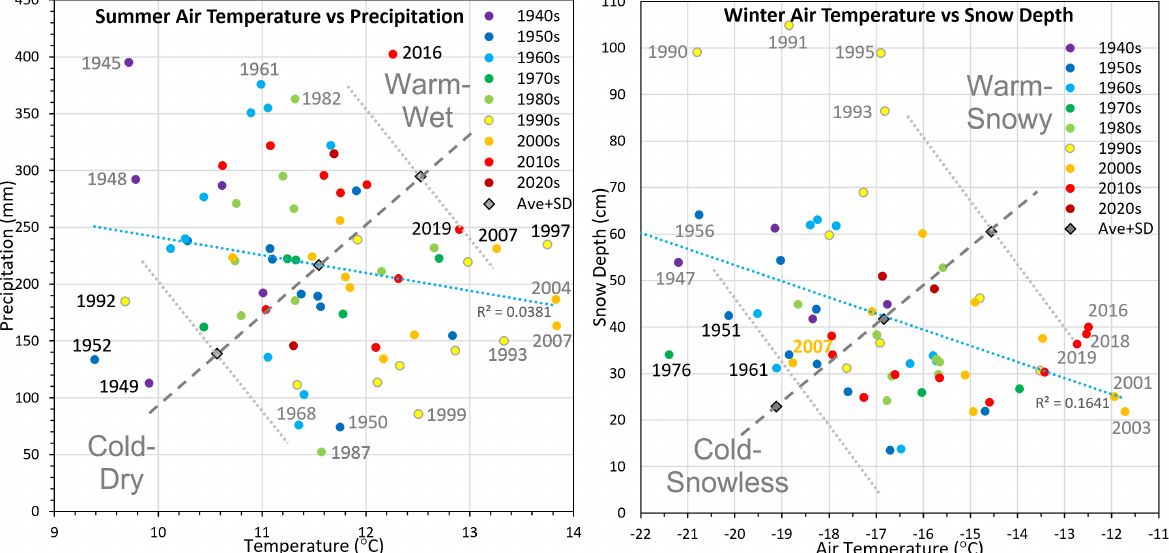
Figure 2. Summer (MJJAS) mean air temperatures versus cumulative precipitation ( left ) and winter (NDJFM) mean air temperatures versus mean snow depth ( right ). Gray triangles show mean ± SD. Dark gray dashed line represents axis of cold–dry to warm–wet and light gray dotted line delineates extreme values toward the ends. Extreme years along this axis are labeled in black, while years with either extreme temperature or precipitation are labeled in gray. Regression lines ( blue, dotted ) indicate little relationship between temperature and precipitation.